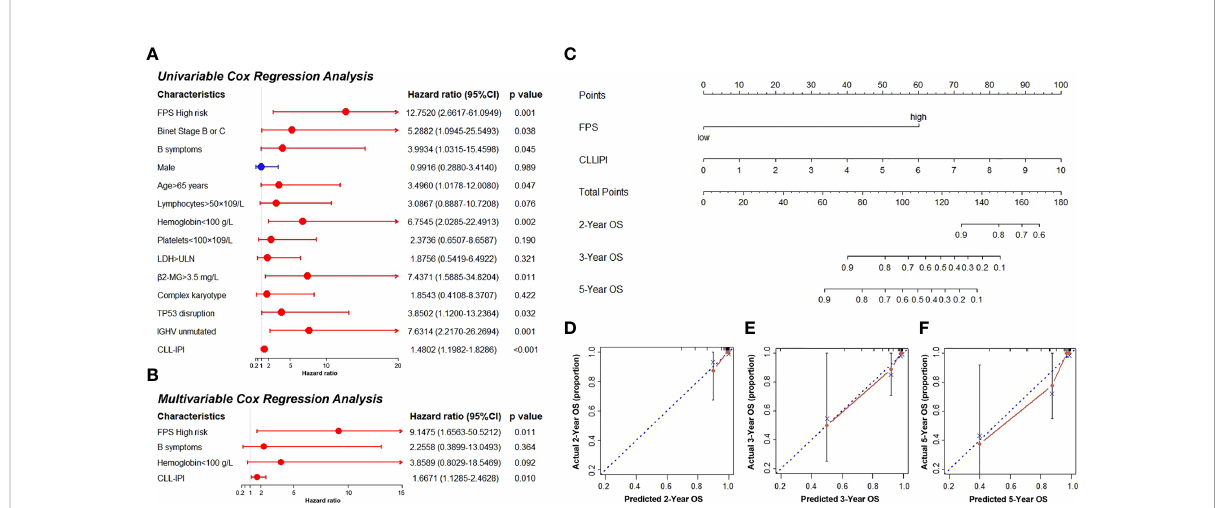
FIGURE 6 (A, B) The univariate and multivariate Cox regression model analyses for assessment of the prognostic value of clinical characteristics and PFS. (C) The nomogram model for predicting 2-, 3-, and 5-year OS rate of CLL patients. (D – F) The calibration plot analysis to assess the nomogram accuracy for OS prediction at 2, 3, and 5